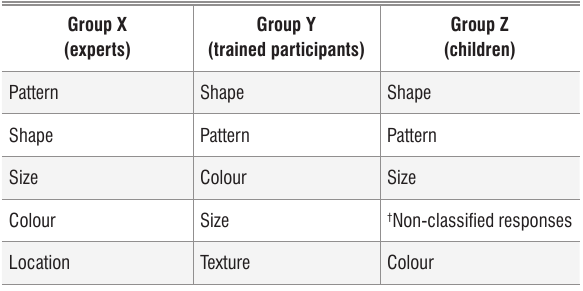
Summarised flow of mental cognition counts of image A